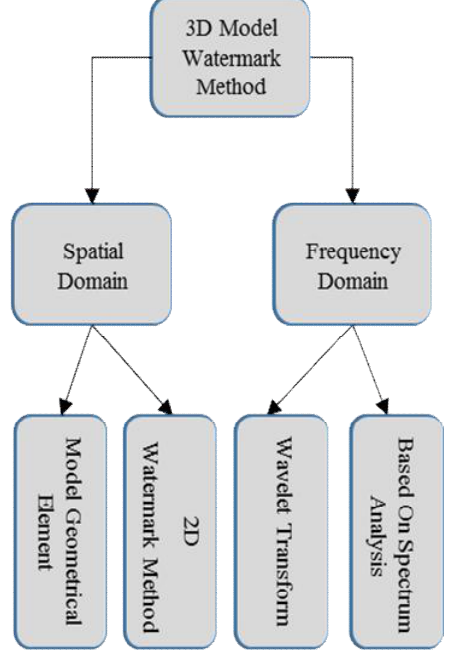
Figure 5.3-d watermarking